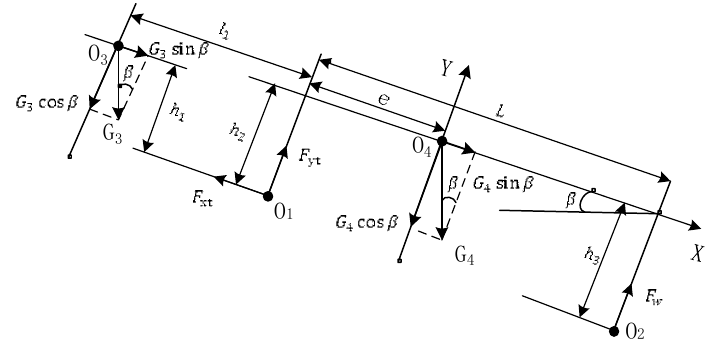
Figure 5. Force schematic of the rape windrower when climbing up.